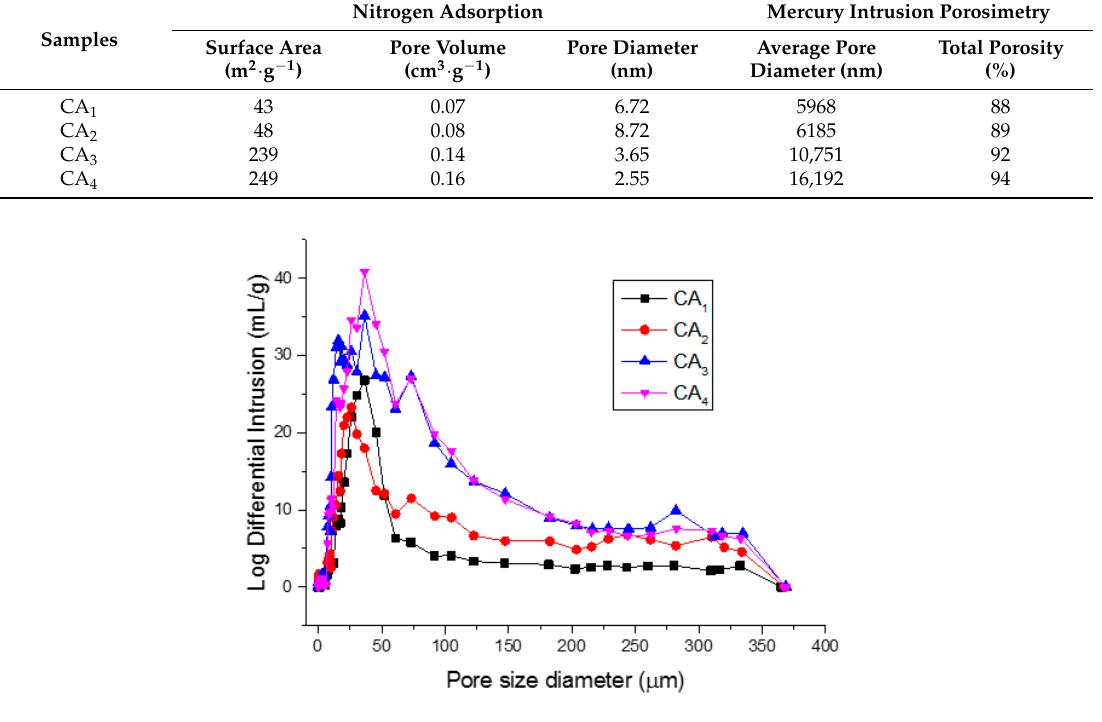
Figure 4. Pore size distribution of carbon aerogels.